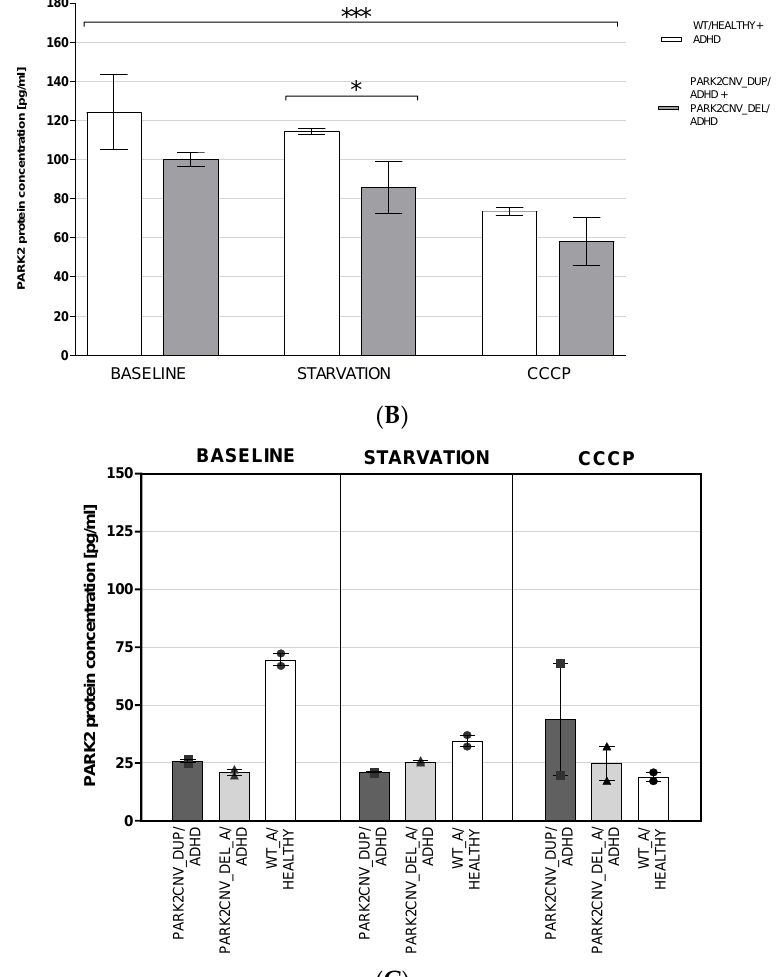
Figure 2. ( A – C ): PARK2 protein concentration. PARK2 protein concentration was evaluated in HDF lines ( A + B ) and mDANs ( C ) in baseline conditions and after 24 h nutrient deprivation (=starvation) stress and after treatment with 10 µM CCCP for 24 h. PARK2 protein data were obtained from two independent experiments (HDF, only one experiment in mDAN) with samples measured in duplicates. Data are shown as mean ± SEM. Exploratory ANOVA was calculated. A show the data from HDF cell lines from PARK2 CNV duplication vs. deletion vs. wildtype healthy control separately, C shows a combined analysis of HDF data of PARK2 CNV deletion + duplication vs. wildtype ADHD + healthy to increase number of cell lines and statistical power. Level of significance was set at p = 0.05. * p ≤ 0.05; *** p ≤ 0.001.